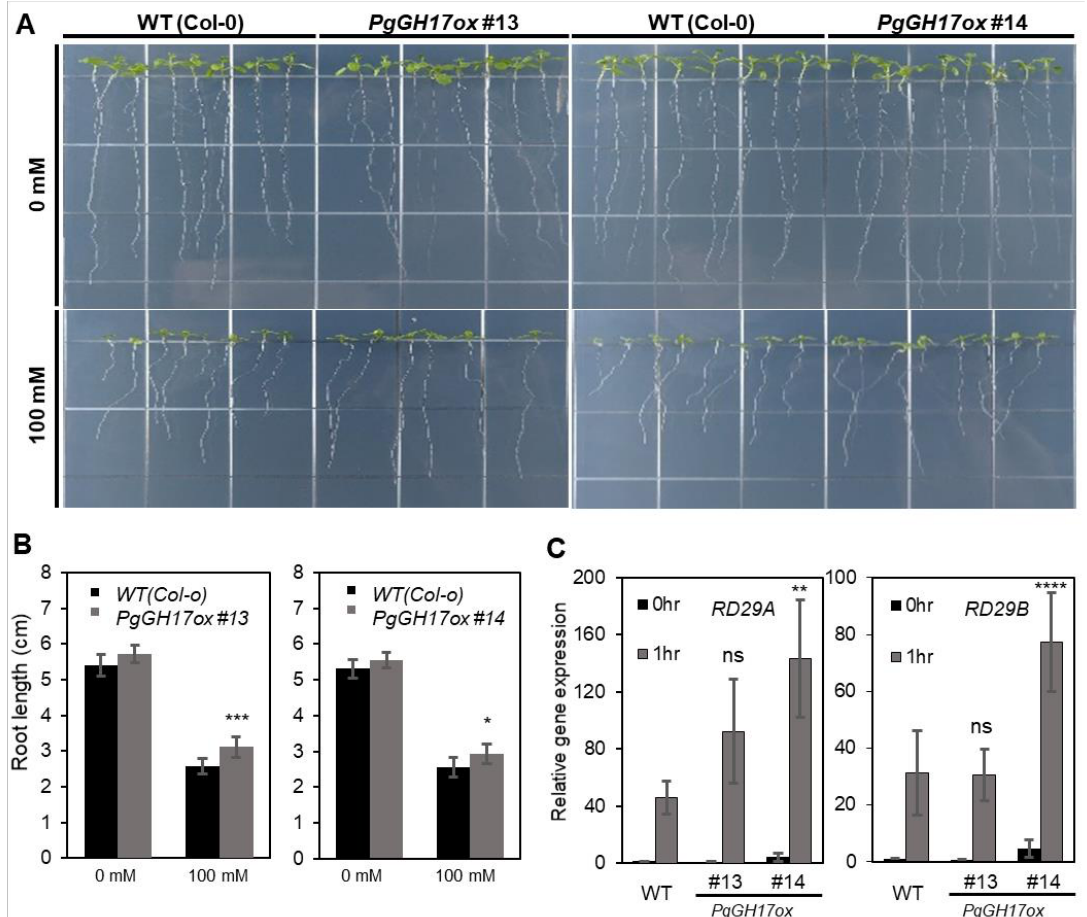
Figure 6. Salt tolerance of PgGH17 -overexpressing plants. ( A ) Ten day-old seedlings with WT (Col-0) PgGH17ox were grown in ½ MS media with 100 mM NaCl. ( B ) Primary roots were photographed and analyzed with ImageJ software (https://imagej.nih.gov/ij, USA, accessed on 16 March 2022). The raw data were statistically analyzed using the Student’s t -test, and p -values were obtained using at least 35 seedlings per treatment. The error bars represent SE. ( C ) Induction of RD29A and RD29B salt-responsive genes after 1 h 150 mM NaCl treatment in HA-GHs overexpression lines. Asterisks indicate a significant difference between WT and PgGH17 -overexpressing plants. (ns indicates no significance, * p < 0.05; ** p < 0.01; *** p < 0.001; **** p < 0.0001; the Student’s t test).